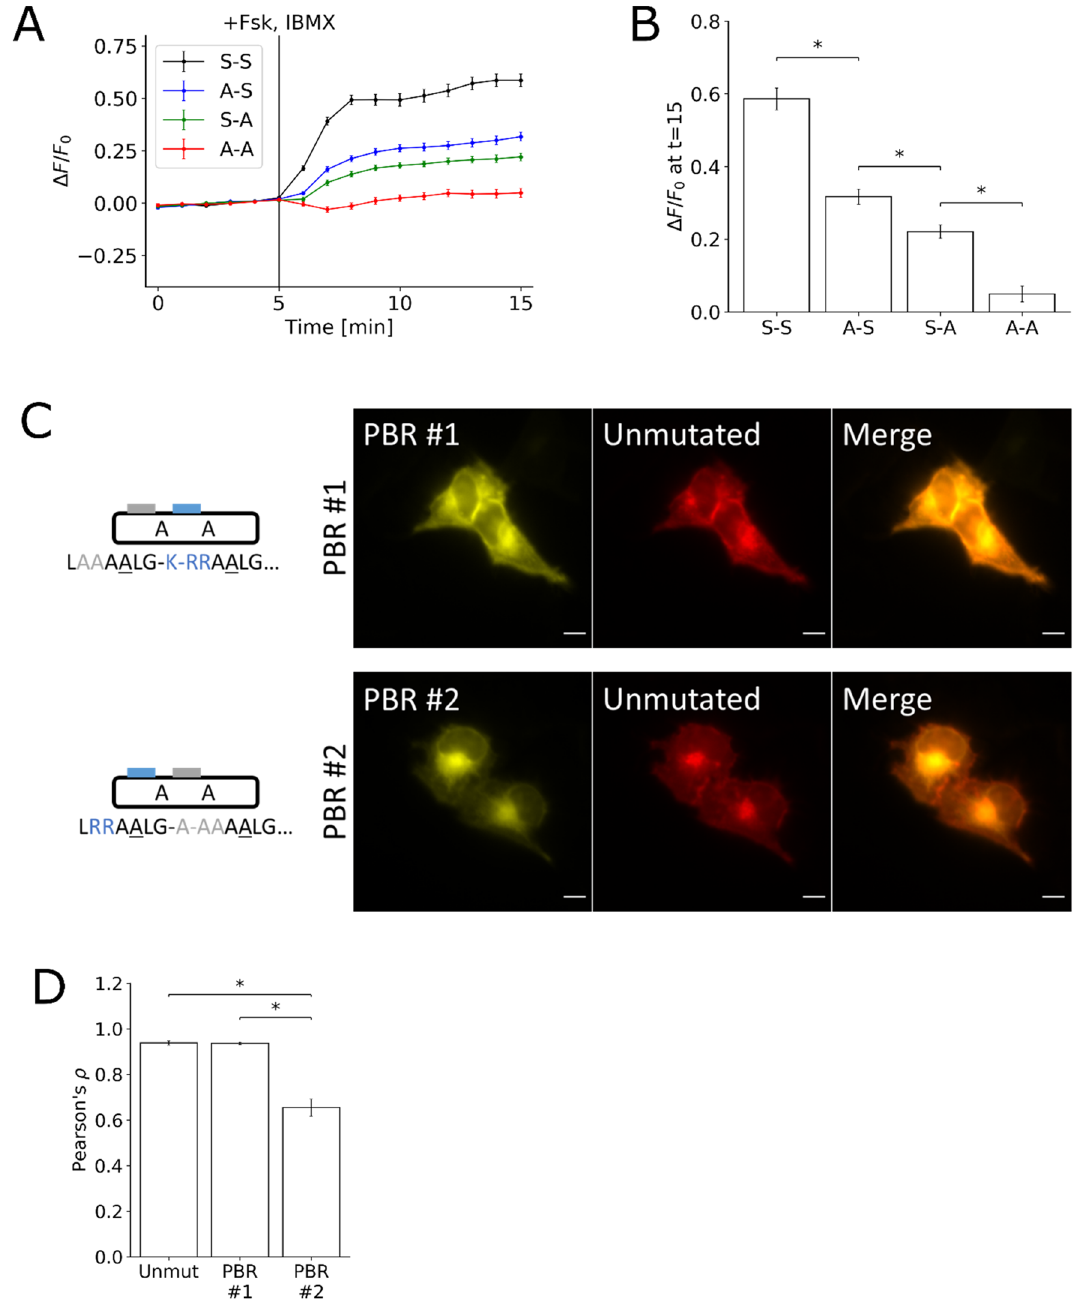
Figure 3. Role of Positively Charged Residues in Phosphorylation-Dependent Translocation. (A) Time- profile shows quantification of peptides with various permutations of non-phosphorylable FES-PKA. In the notation S–S, the first letter represents whether the first phosphorylation site is mutated, and the second letter represents whether the second phosphorylation site is mutated. (B) Bar chart represents the signal change for each of the mutations 10 min after PKA stimulation. (C) Micrograph represents cell images containing mutations disrupting the positively charged residues in the two clusters of basic residues, respectively. (D) Bar chart represents the average Pearson’s correlation calculated by comparing the three different peptides against their unmutated counterpart. All data points in Figs. 3A and 3B represent data collected from 30 cells over 3 independent experiments (10 cells each), and error bars represent standard error of mean. * represents statistical significance: p < 0.05. Scale bar represents 10